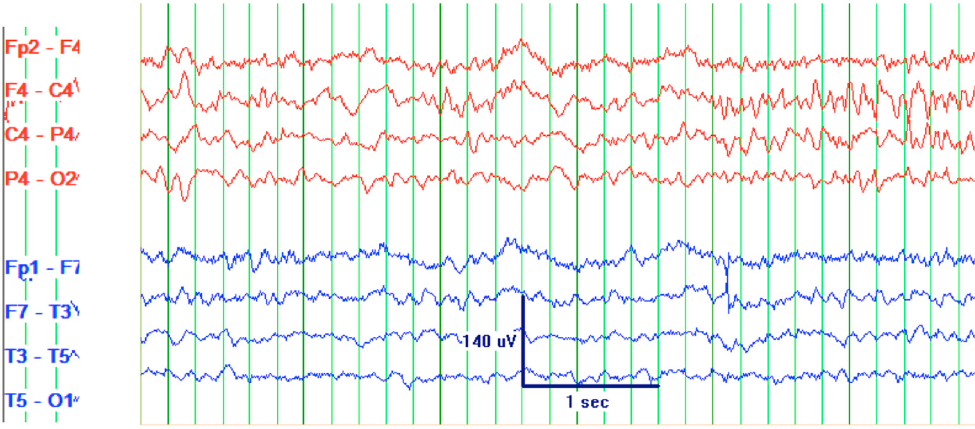
Figure 2. Electroencephalogram ( EEG) of a 61-year-old male with SCNS-DLBCL presenting with acute encephalitis. Consistent with an abnormal EEG reading due to mild-moderate diffuse slowing. This specific frame shows excess low to moderate voltage (15 to 40 uV) polymorphic delta and theta activity. Interpretation of this EEG suggests mild to moderate diffuse cerebral dysfunction. Technical information: Electrodes were placed according to the 10–20 International Electrode System. Digital EEG was recorded using the Natus Digital EEG System and EEG was reformatted into multiple montages as needed.